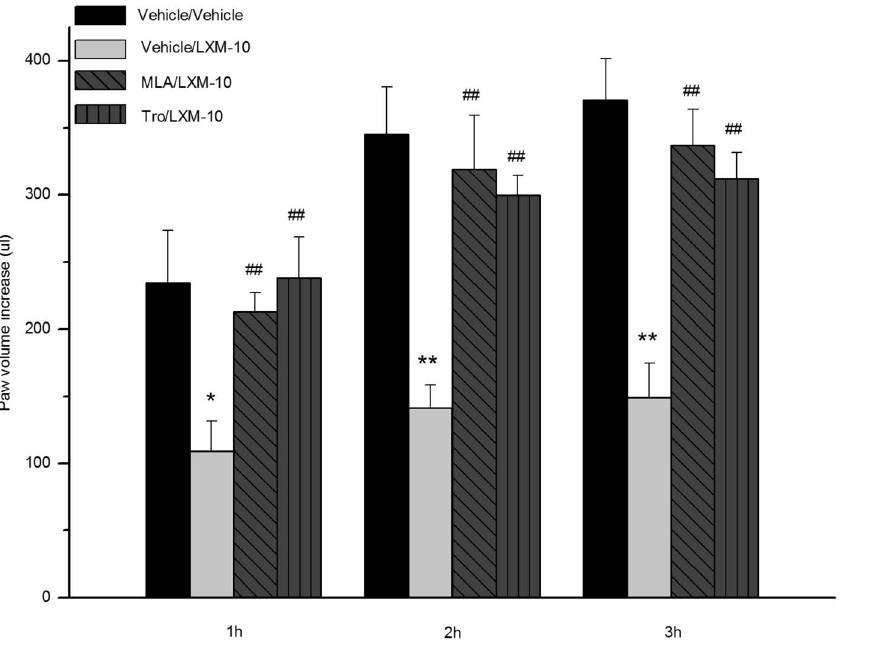
Figure 2. Effect of LXM-10 on carrageenan induced rat paw edema was attenuated by methyllycaconitine citrate and tropicamide. The rats were treated with methyllycaconitine citrate (MLA, 3 mg/kg, i.p.), tropicamide (Tro, 3 mg/kg, i.p.) or vehicle before administration of LXM-10 (6 mg/kg, i.g.) or vehicle. The paw volume was measured at 1, 2 and 3 h after challenged by carrageenan. All data are mean 6 SEM of 8 rats per group. * P , 0.05 and ** P , 0.01 vs Vehicle/Vehicle; ## P , 0.01 vs